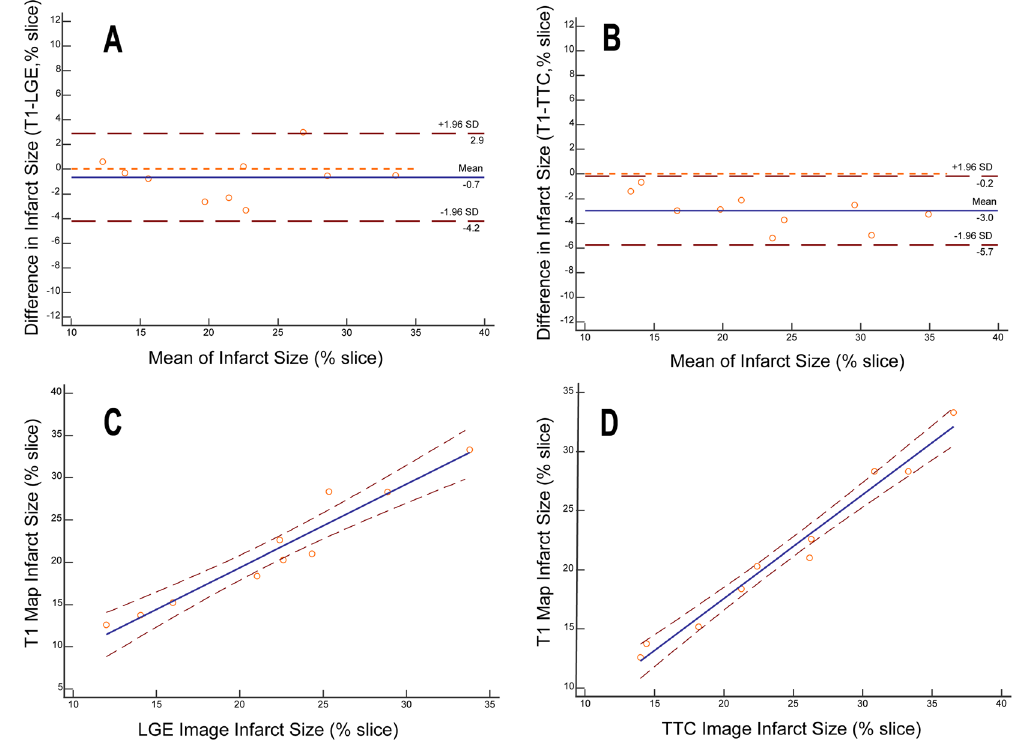
Figure 3. Infarct size assessed by T1 mapping, LGE imaging and TTC staining. Legend: Bland-Altman analysis shows good agreement in the measurement of infarct size between the T1 maps and LGE images ( A ) as well as between the T1 maps and TTC staining images ( B ). The blue line indicates the mean of infarct size. The dashed red line indicates 95% CI. There is good correlation between the LGE images and T1 maps, y = − 0.41% + 1.00x, R 2 = 0.93, p < 0.0001, ( C ) as well as between the TTC staining images and the T1 maps, y = − 0.02% + 0.88x, R 2 = 0.98, p < 0.0001, ( D ) in measuring the infarct